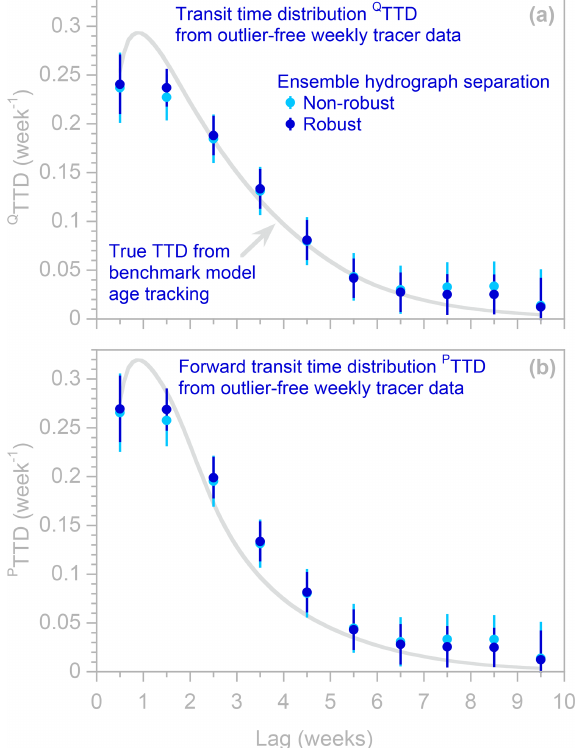
Figure 8. Transit time distributions ( Q TTDs) and forward tran- sit time distributions (transit time distributions of precipitation, P TTDs), as estimated by ensemble hydrograph separation from syn- thetic weekly benchmark tracer time series. Symbols show ensem- ble hydrograph separation results obtained with and without robust estimation (dark and light symbols, respectively); error bars indicate 1 standard error. Many light blue symbols are obscured because they are overprinted by dark blue symbols. The light gray lines indicate the true TTDs, as calculated from water age tracking in the bench- mark model. The tracer data used here are the same as in Fig. 6 but aggregated to simulate weekly instead of daily sampling. The standard errors are not as overestimated as those in Fig. 6, because weekly sampling results in weaker serial correlation in the residuals of the regressions that estimate the TTD (see Fig. 7).